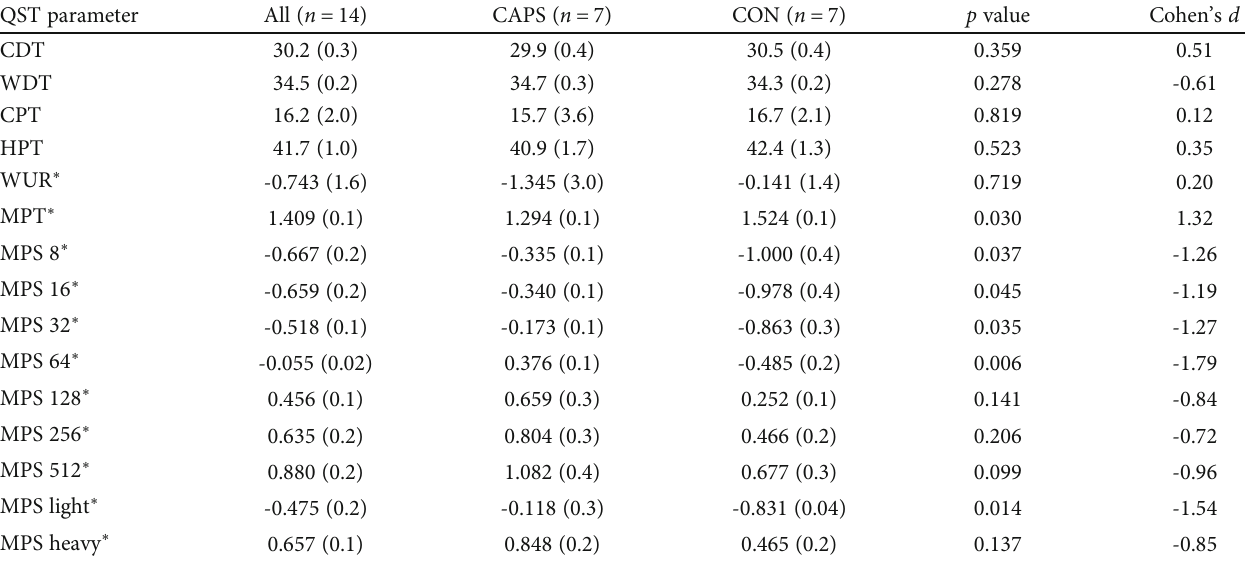
Table 1: Average QST parameters. Asterisks indicate log-transformed pain ratings prior to statistics.